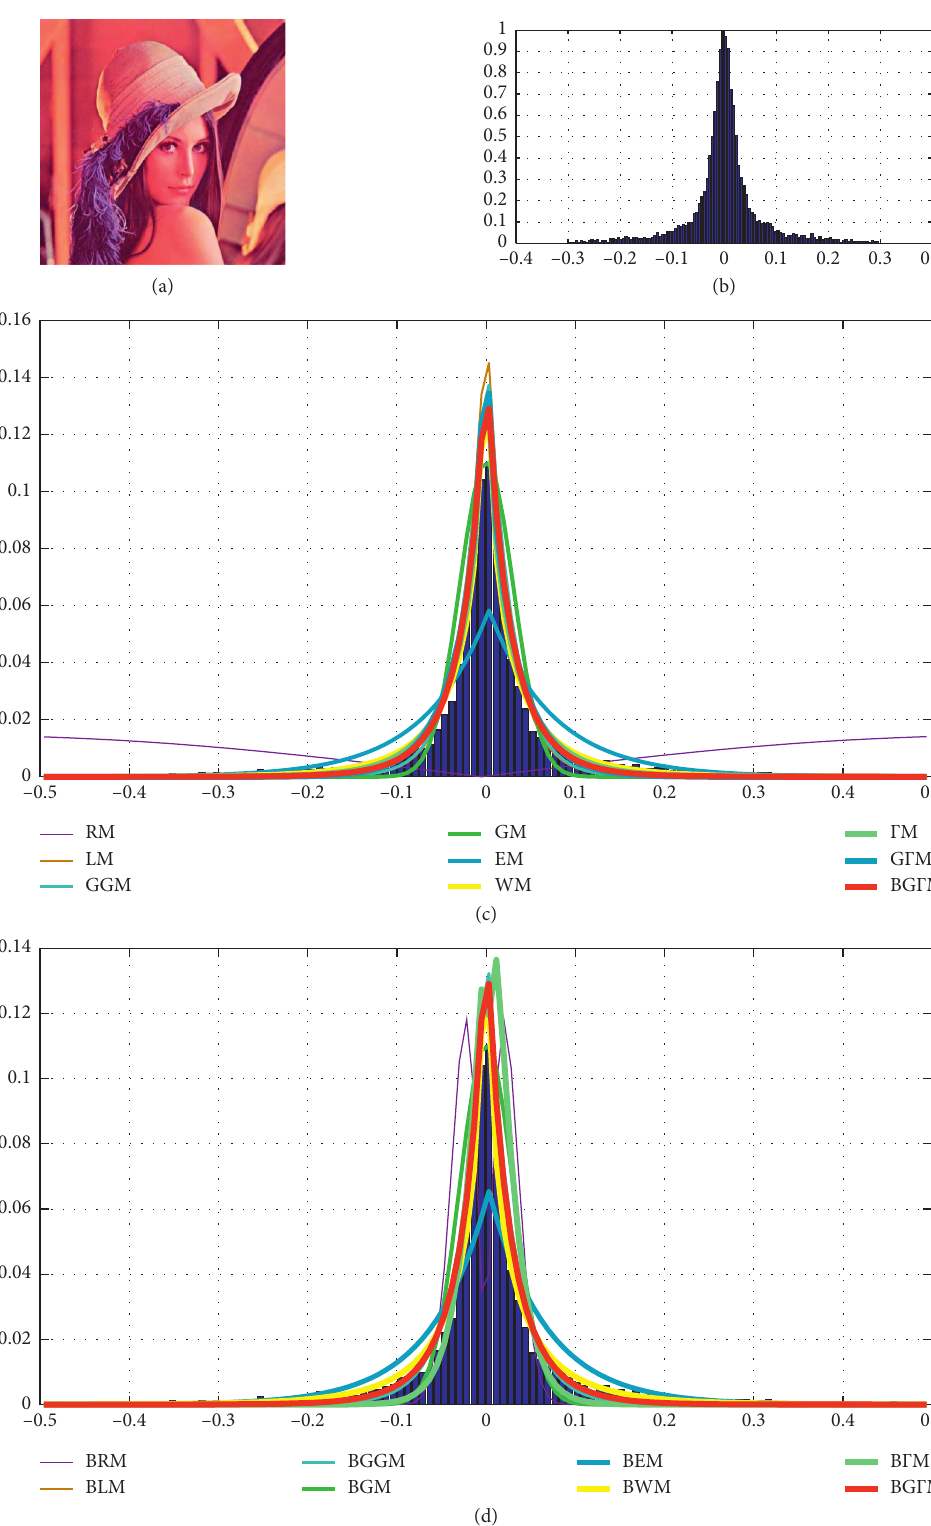
Figure 12: Approximation of the wavelet coefficients. (a) The original image (lena); (b) the wavelet coefficient (db4, CD, level 1) of lena image in ( − 0.5, 0.5); (c) the estimated histogram of RM, LM, WM, GM, EM, GGM, Γ M, G Γ M, and G Γ M; (d) the estimated histogram of BRM, BLM, BWM, BGM, BEM, BGGM, B Γ M, and BG Γ